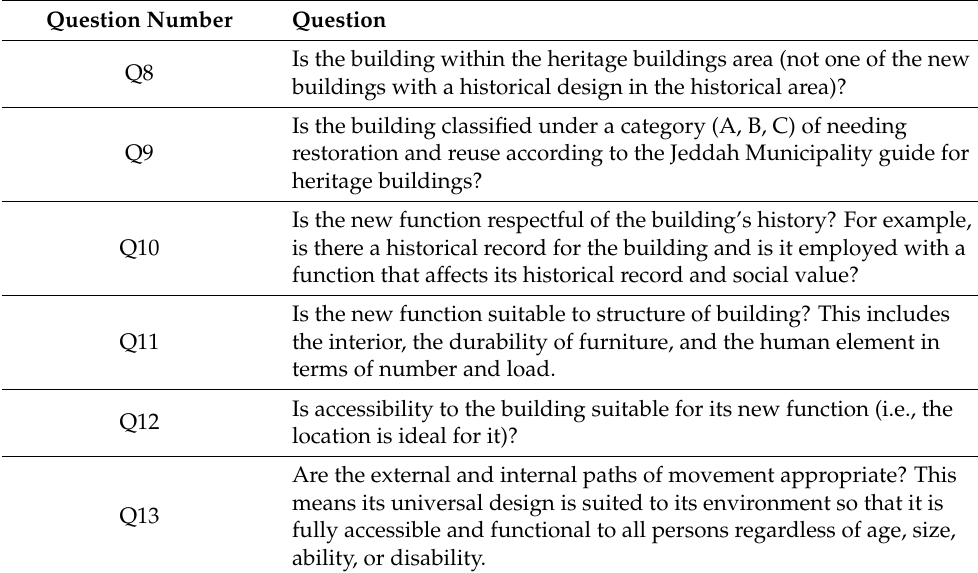
Table 3. Questions related to the suitability of the new function.